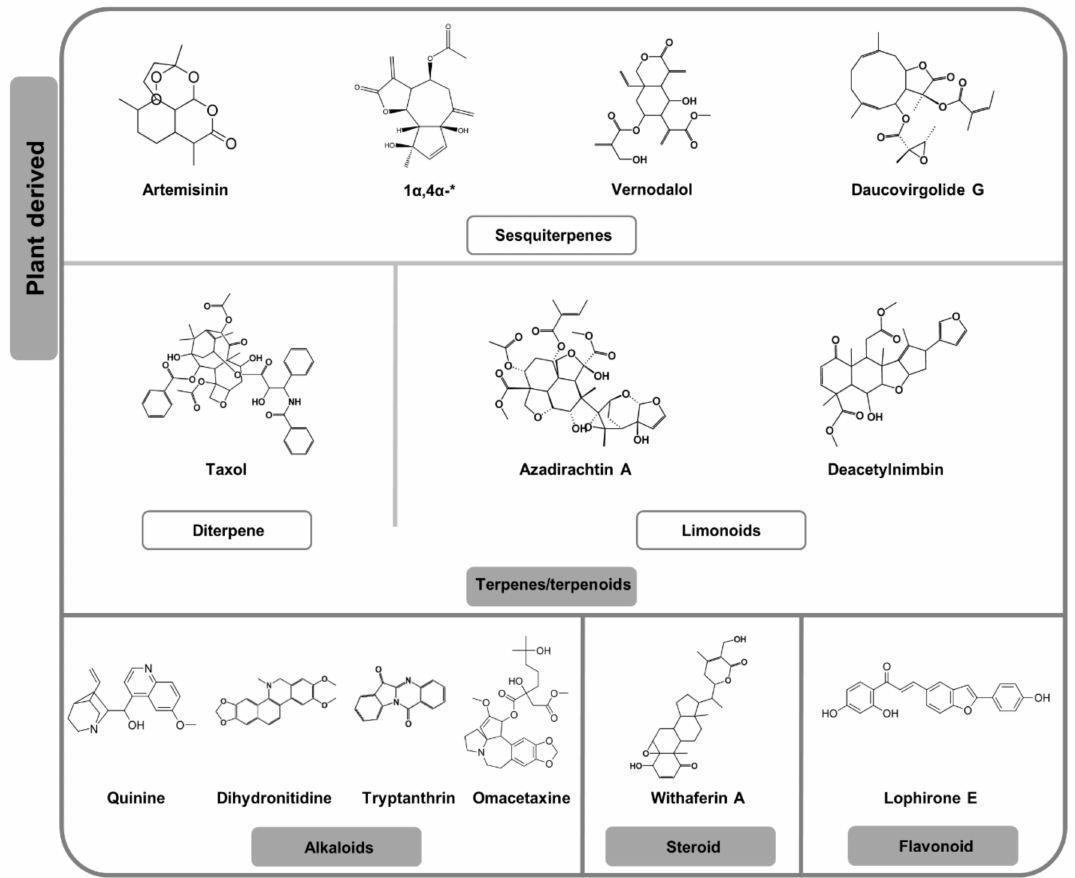
Figure 3. Chemical structures of selected plant-derived compounds with some described activity (includingonlymoderate)against P.falciparum transmissiblestages. *1 α ,4 α